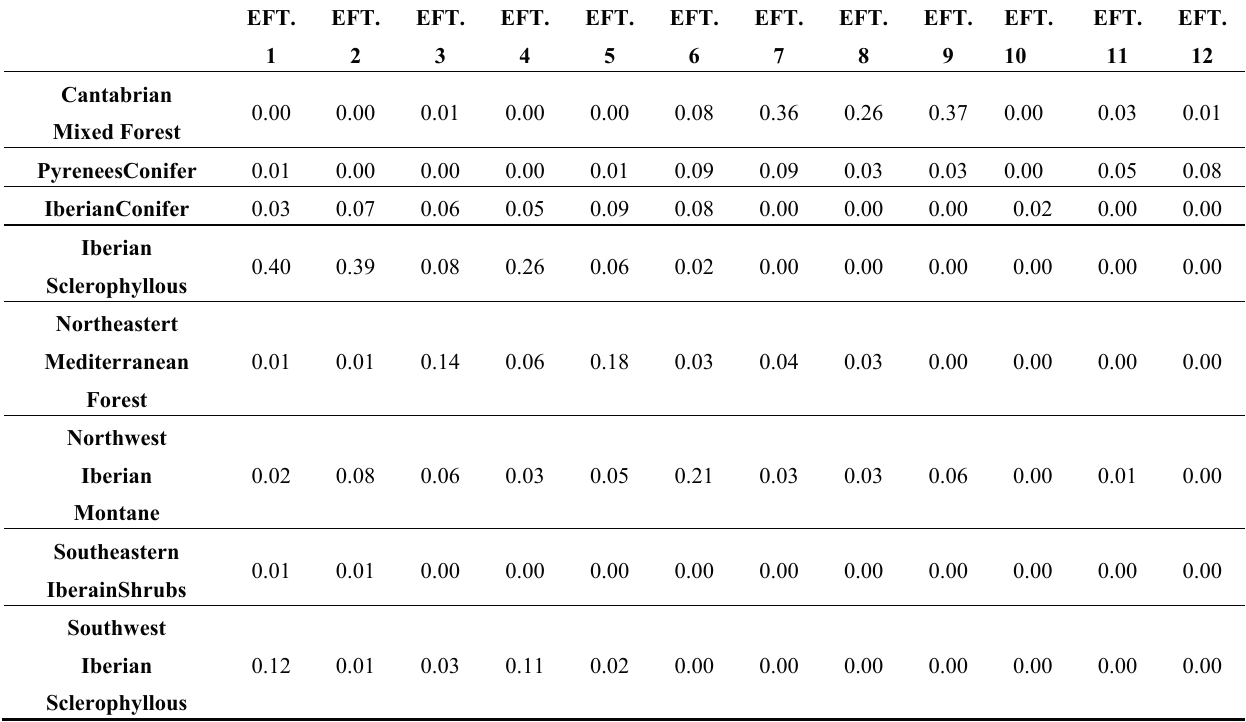
Table C. Minnick’s coefficient (Cm) to show the degree of overlap between the land cover dataset and the